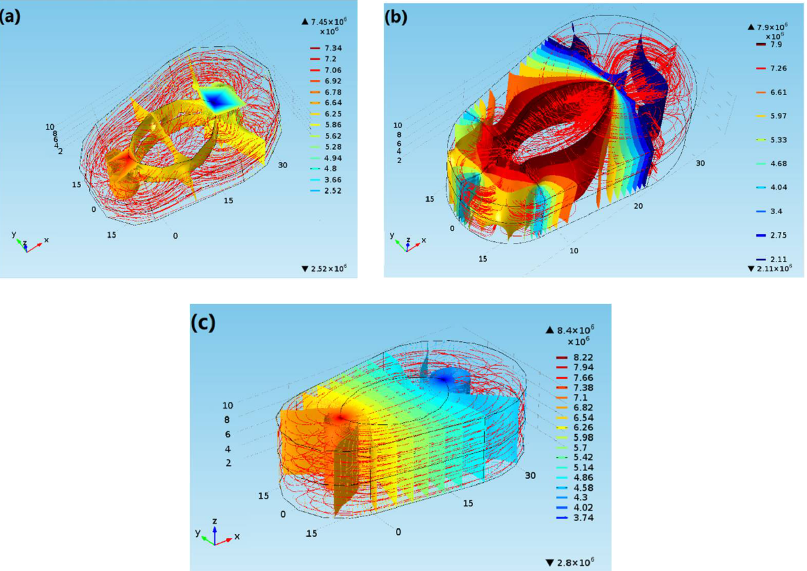
Figure 5. Cloud distribution of pressure distribution in the oil shale reservoir during heating process. ( a ) the initial stage of pyrolysis ( b ) the middle stage of pyrolysis ( c ) the later stage of pyrolysis.